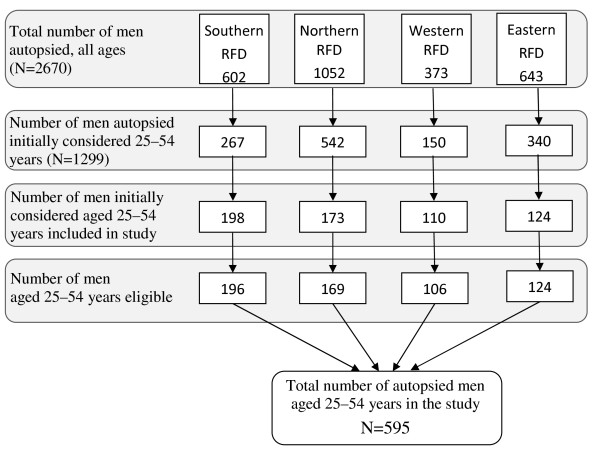
Selection of study subjects by Regional Forensic Departments (RFD) of the Estonian Forensic Science Institute. All four Regional Forensic Departments in Estonia participated in the study. During the study period (15 January 2008-11 September 2009), 3427 autopsies were performed by the Estonian Forensic Science Institute, 2670 (77.9%) of which were male. Of these, 1299 subjects were initially determined to be within the designated age range of 25-54 years.